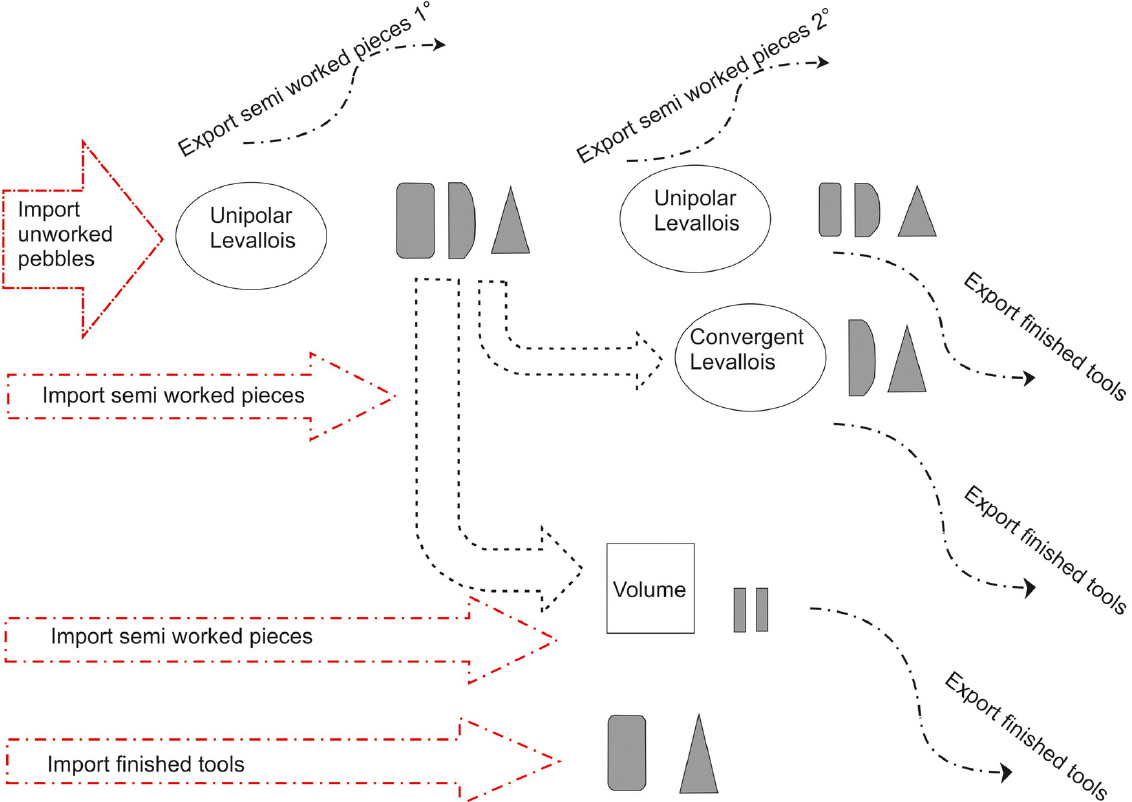
Figure 7. Fragmented reduction sequences. The grey silhouettes represent the target flakes (big rectangle = flakes; triangle = convergent flakes; half oval = backed flakes; small rectangle =